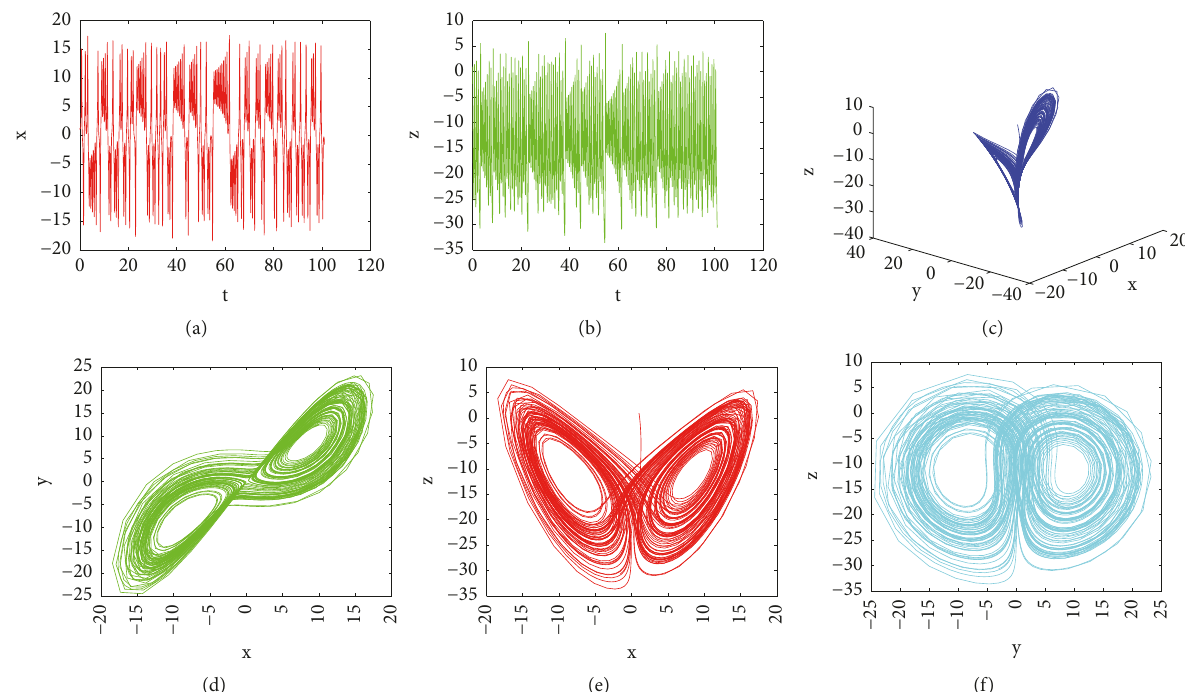
Figure 12: Lorenz system for Experiment 4 with 𝑎 = 10, 𝑏 = 8/3,𝑐 = 28 : (a) time series plot of 𝑥 ; (b) time series plot of 𝑧 ; (c) on the three-dimensional space; (d) projected on the (𝑥,𝑦) -plane; (e) projected on the (𝑥,𝑧) -plane; (f) projected on the (𝑦, 𝑧) -plane.